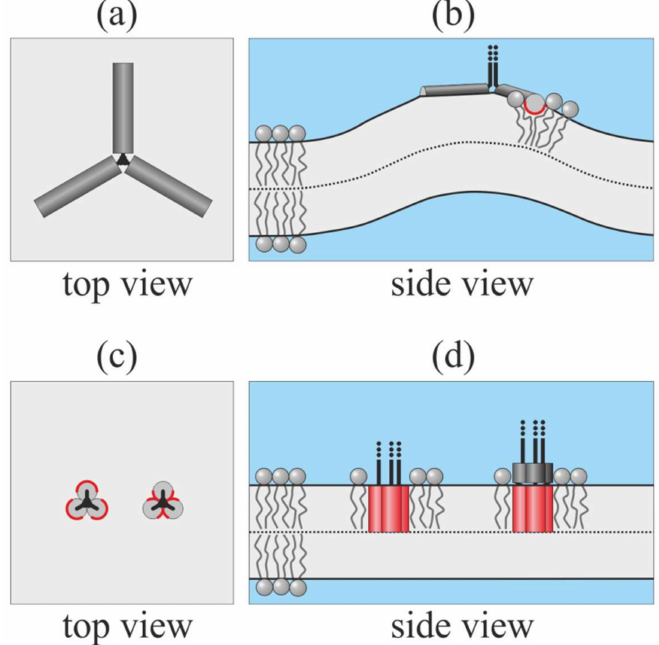
Figure 1. Possible ways of insertion of fusion peptides from one trimer of the type I fusion protein into the target membrane. Shallowly inserted amphipathic fusion peptides strongly deform the membrane: ( a ) top view; ( b ) side view (the 3rd peptide is not shown). When fusion peptides are in trans-monolayer configuration, the deformation is minimal: ( c ) top view; ( d ) side view. The polar side surface of the peptide is shown in dark gray; the hydrophobic side surface is shown in red. In panels ( c ), ( d ), the left configurations correspond to predominantly hydrophobic fusion peptides with a small area of the polar surface; the right configurations correspond to fusion peptides, whose hydrophobicity gradually increases from the C- to N-terminal, modeling the fusion peptides of influenza A virus hemagglutinin